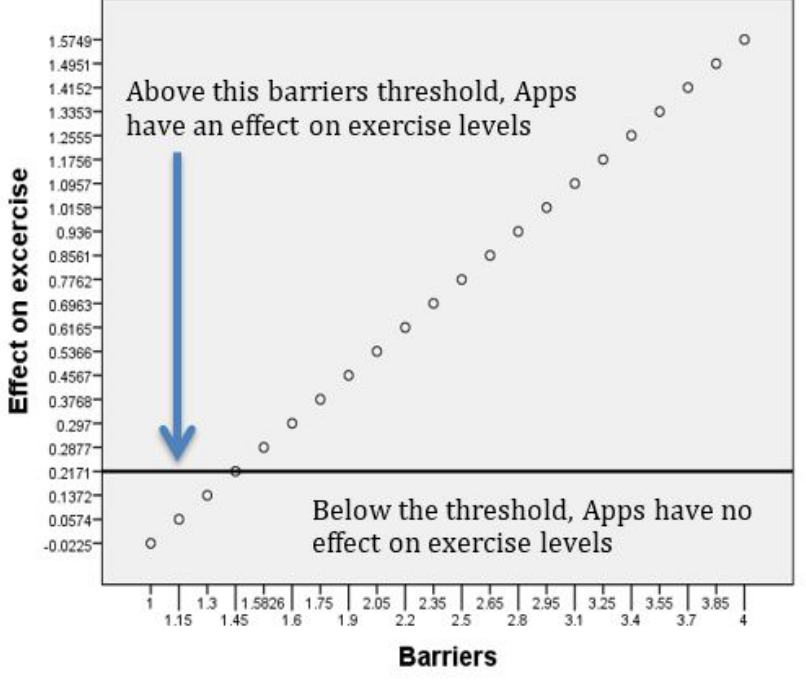
Figure 2. Relationship between app use and exercise at different levels of the continuous barriers to exercise